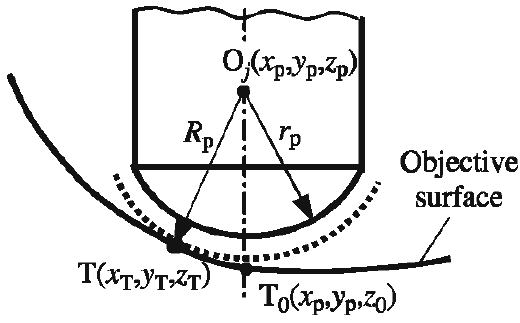
Fig. 5. The maximum contact area between the bunch and the forming